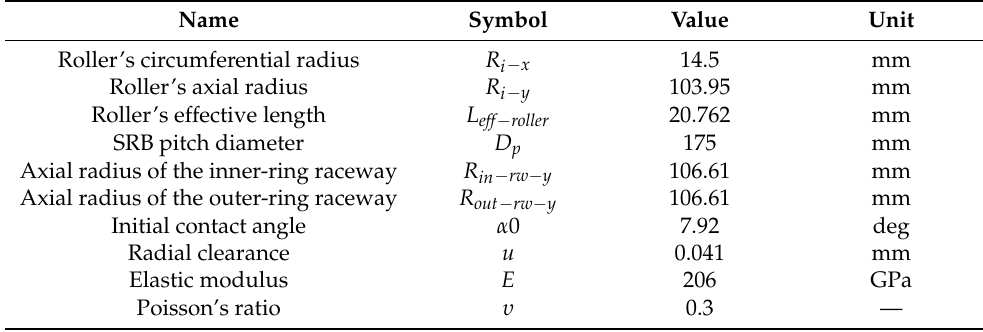
Table 1. SRBs’ fundamental geometrical and material